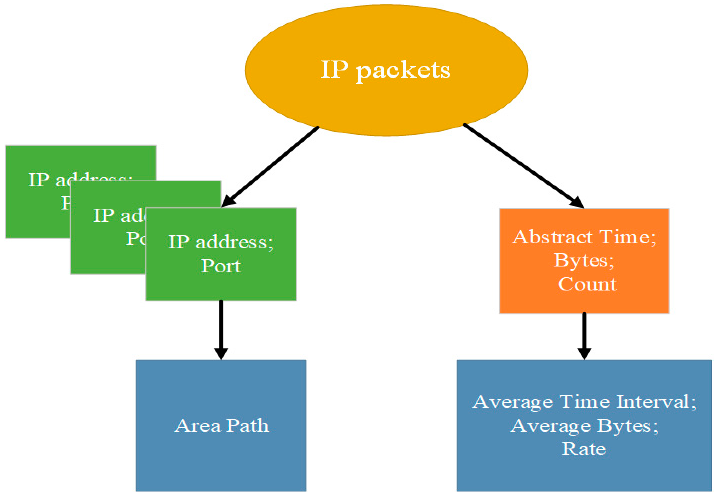
Figure 2. Features extraction.